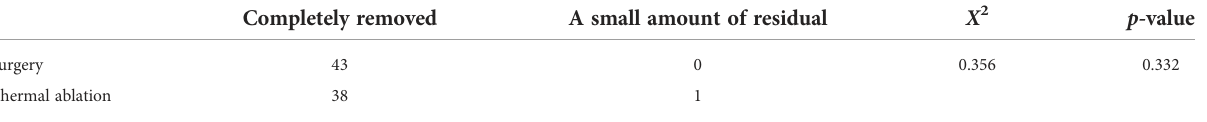
TABLE 2 Comparison of curative effect between surgery and thermal